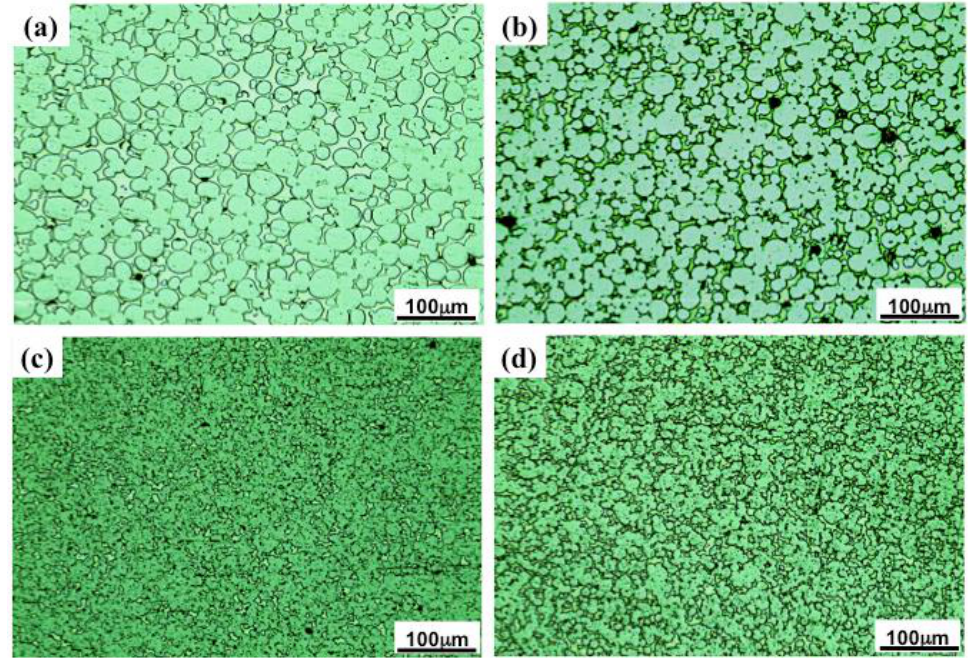
Figure 3. Optical microscope images of the sintered ( a ) W3Mo, ( b ) W12Mo, ( c ) W3Mo-YO, and ( d ) W12Mo-YO model alloys milled for 24 h.